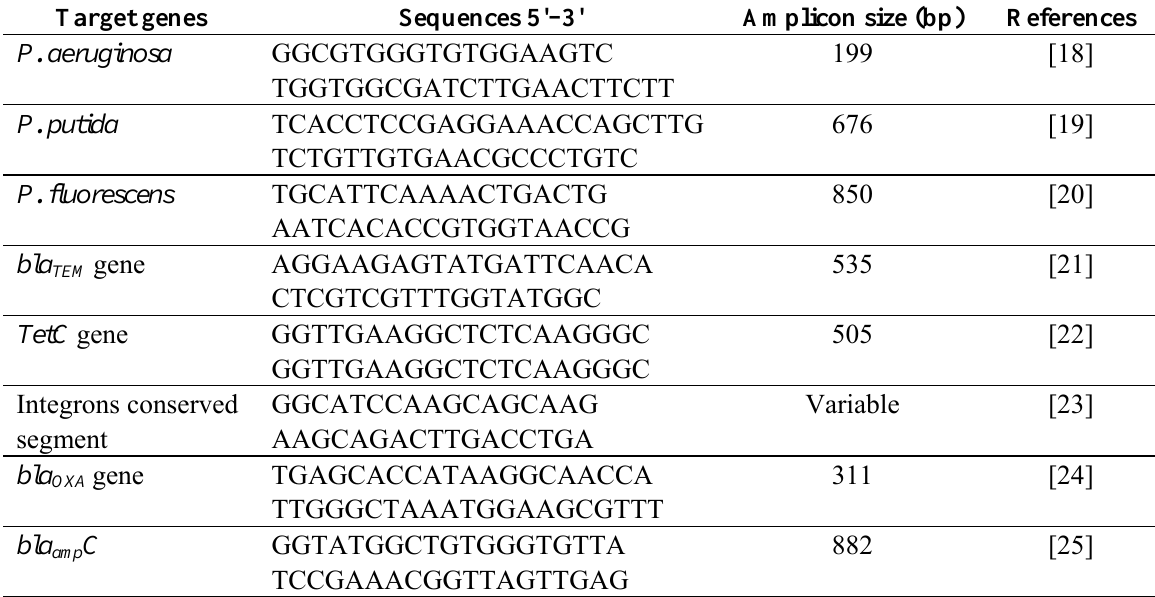
Table 1. List of Primers used in this